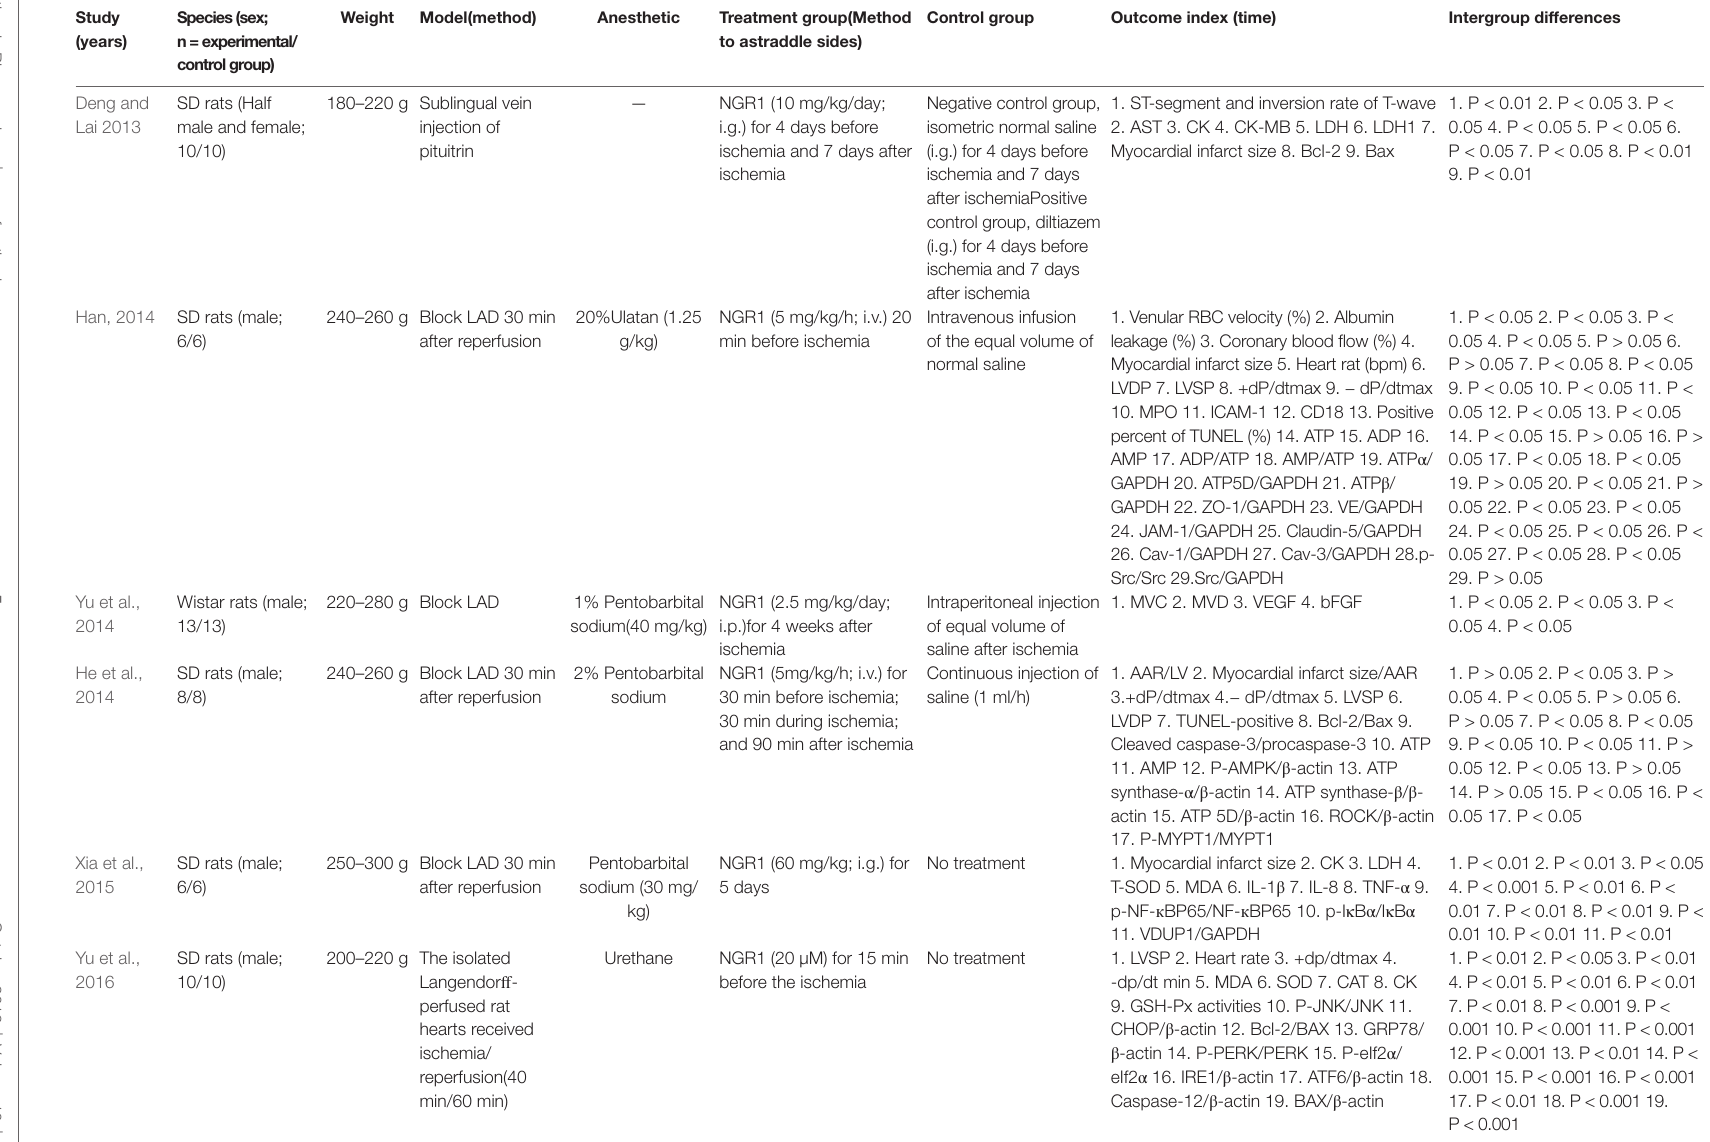
TABLe 1 | Characteristics of the 14 included animal